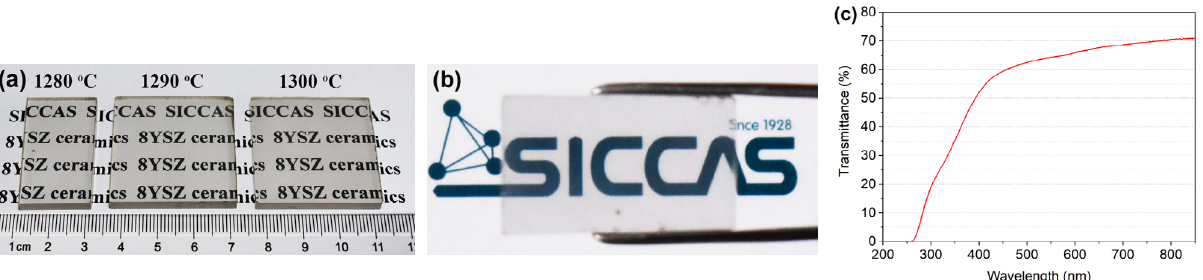
Fig. 10 (a) Photographs of the 8YSZ transparent ceramics (4.0 mm in thickness) pre-sintered at 1280, 1290, and 1300 ℃ for 4 h and HIP post-treated at 1550 ℃ for 3 h, (b) picture of the 8YSZ transparent ceramics (4.0 mm in thickness) pre-sintered at 1280 ℃ (the sample is 100 mm positioned above the background), and (c) in-line transmission curve of the 8YSZ transparent ceramics shown in (b).